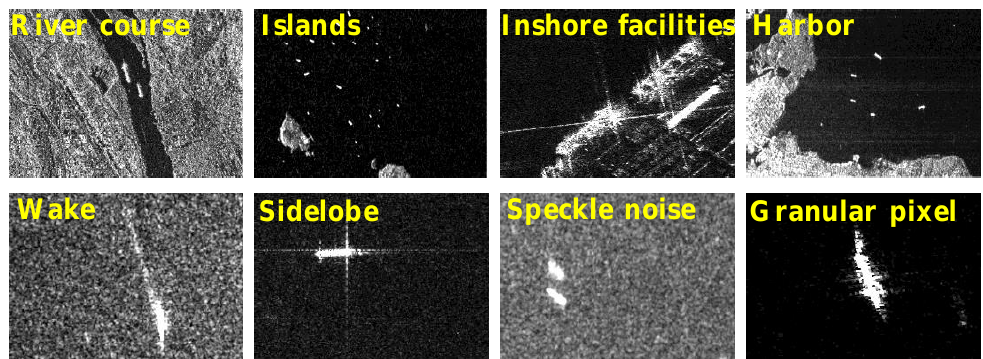
Figure 2. Various surroundings of ships in SAR images.